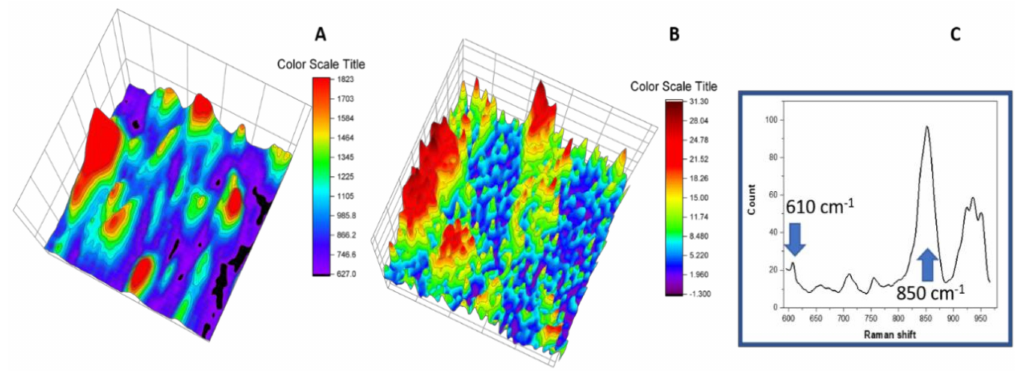
Figure 5. Raman imaging results of dried Chi:HPCD 2:50 fiber after soaking with Rhodamine 6G in a benzene solution, where a sample Raman spectrum centered at 790 cm − 1 was given under static conditions ( λ ex = 785 nm). The Raman spectral image of the HPCD area ( A ) was constructed by peak integration at 850 cm − 1 . The Raman spectral image of chitosan in area ( B ) was constructed by dividing the spectral intensity for Rhodamine 6G (610 cm − 1 ) against that for HPCD (850 cm − 1 ) for each respective 1-D spectrum, where a 1-D Raman spectrum is shown in panel C as an